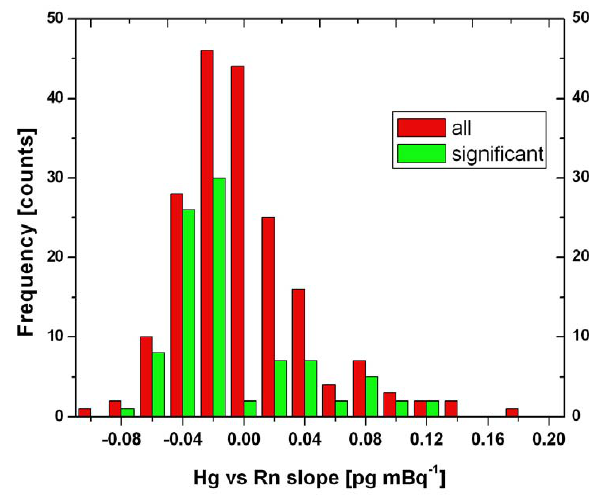
Fig. 1. Monthly frequency of events with 222 Rn concentrations Fig. 1: Monthly frequency of events with 222 Rn concentrations > 1000 mBq m -3 (“all”) > 1000mBqm − 3 (“all”) and those with significant GEM vs. 222 Rn and those with significant GEM vs 222 Rn correlations (“significant”). correlations (“significant”).